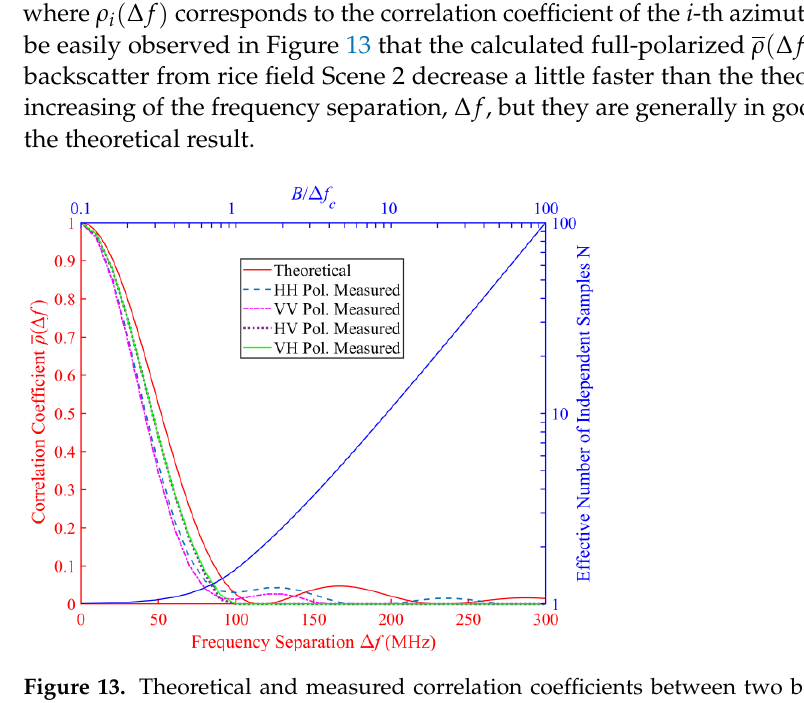
Figure 13. Theoretical and measured correlation coefficients between two backscattered signals sep- arated by the frequency range ∆𝑓 at an incidence angle of 40° (red axis), and the effective number of independent samples, N , as a function of 𝐵 ∆𝑓 𝑐 ⁄ (blue axis).